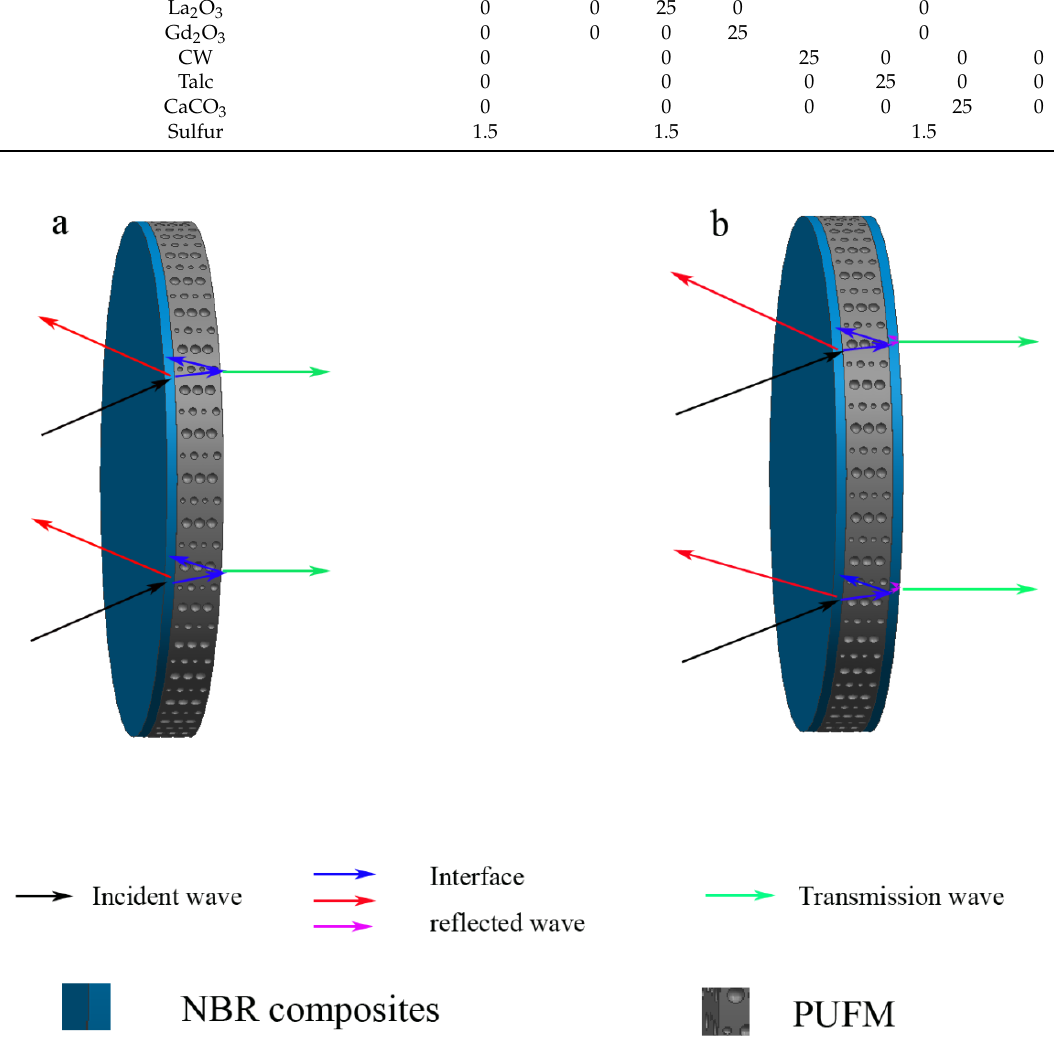
Figure 1. Schematic diagram of the NBR-PUFM composites with different stratified structures: ( a ) double-layer structure; ( b ) sandwich structure.